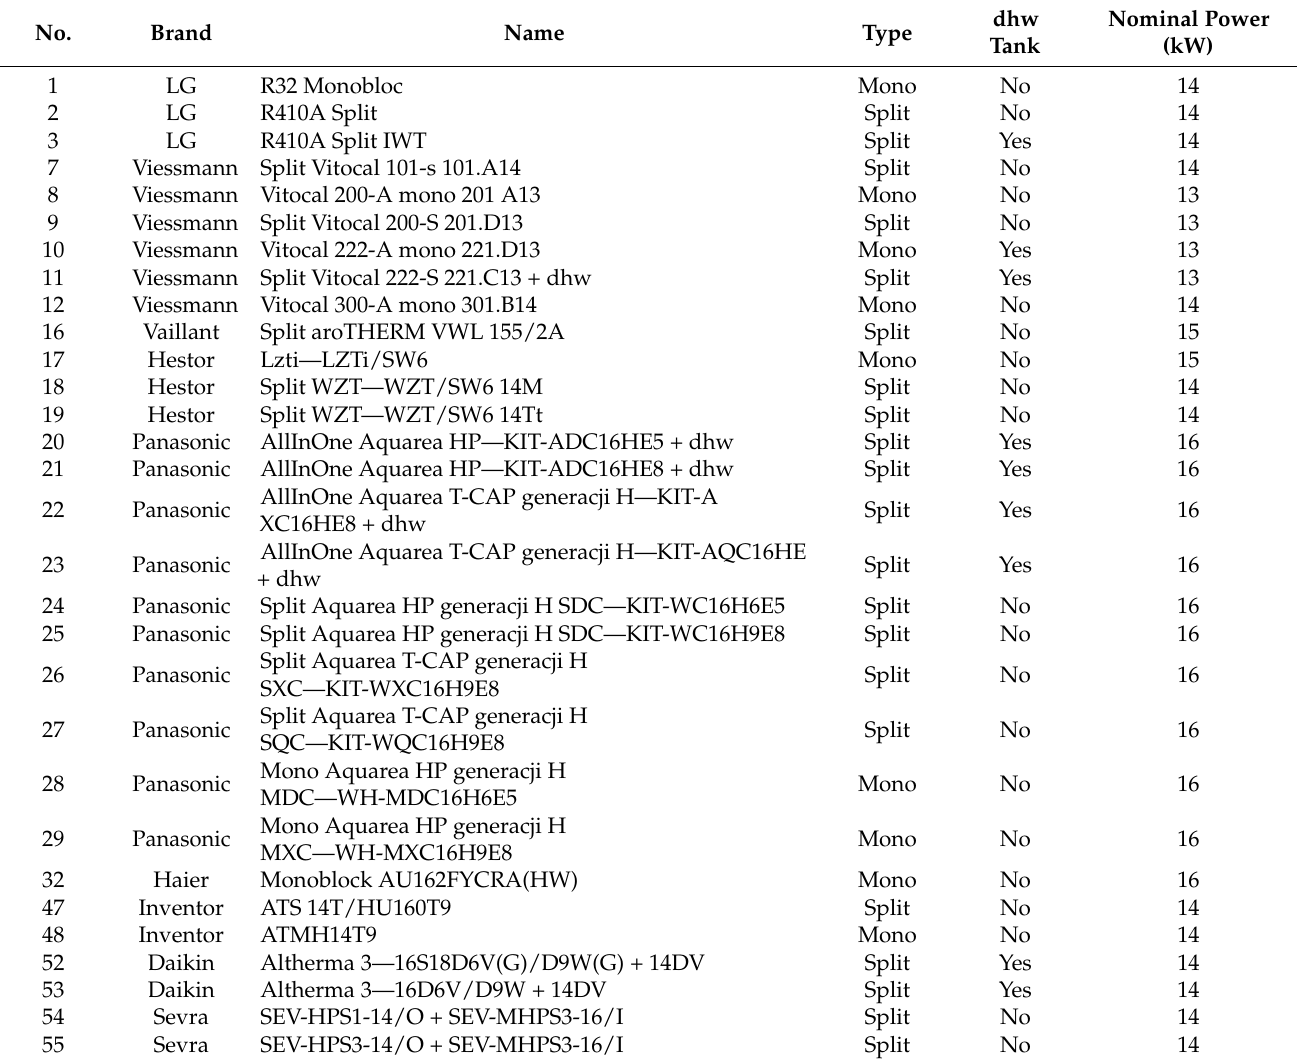
Table A1. Final candidate ASHP devices.